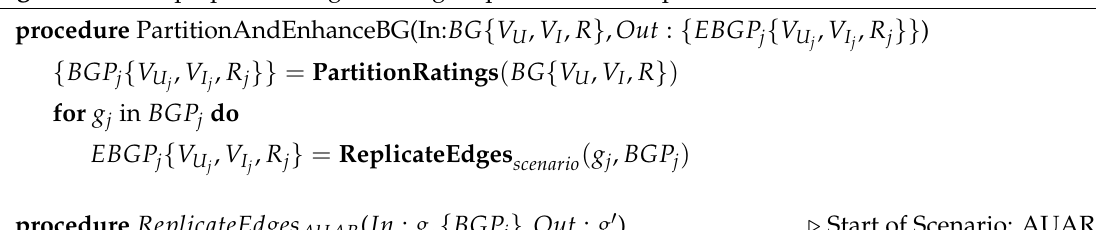
Algorithm 1 Graph partitioning with edge replication across